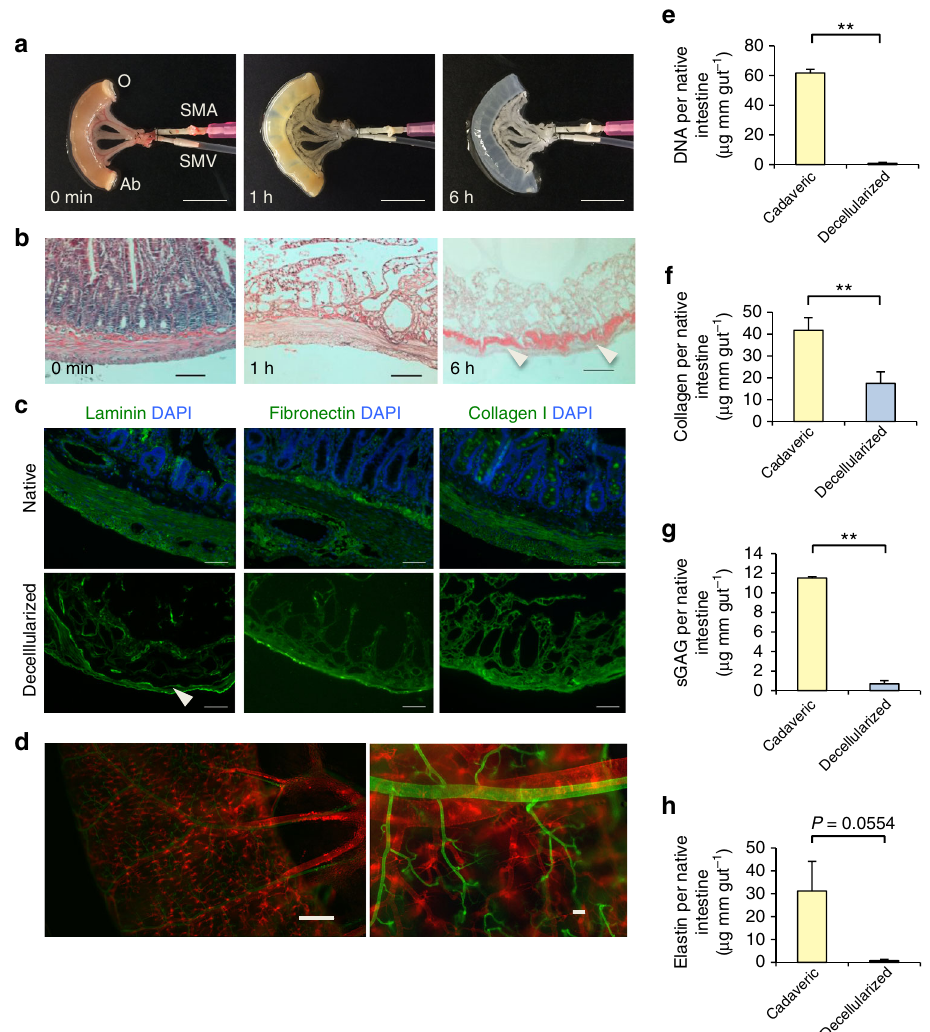
Fig. 1 Perfusion decellularization of rat small intestinal segments. a Time-lapse photographs of a cadaveric rat small intestinal segment undergoing anterograde arterial perfusion decellularization. a Shown are a freshly isolated small intestinal segment ( left ) and the same segment after 1 h ( middle ), and 6 h ( right ) of SDS perfusion. Scale bars , 10 mm. b Representative corresponding hematoxylin and eosin stained sections of rat small intestine during perfusion decellularization. Villous projections and arterioles/venules ( arrowheads ) were preserved after decellularization ( right ). Scale bars , 100 μ m. c Representative immuno fl uorescent stains of cadaveric and corresponding decellularized rat small intestine sections showing the preservation of extracellular matrix proteins laminin, fi bronectin, and collagen I in the absence of cells. White arrowheads indicate the preserved vascular basement membranes. d A representative whole-mount image of decellularized rat small intestine perfused with green- fl uorescent microspheres (0.2 µ m) through the artery and red- fl uorescent microspheres (0.2 µ m) through the vein. Scale bars , 1 mm ( left ) and 100 µ m ( right ). e – h Biochemical quanti fi cation of DNA, total collagen, sulfated glycosaminoglycans (sGAG), and elastin in cadaveric vs. decellularized rat small intestinal tissue showing reductions in DNA content as well as collagen, sGAG, and elastin after perfusion decellularization. The data are normalized in mass per unit length of native intestine. Error bars , mean ± s.d. of experimental values. * P < 0.05; ** P < 0.01, Student ’ s t test. Ab, aboral end of the intestinal lumen; O, oral end of the intestinal lumen; SMA, superior mesenteric artery; SMV, superior mesenteric